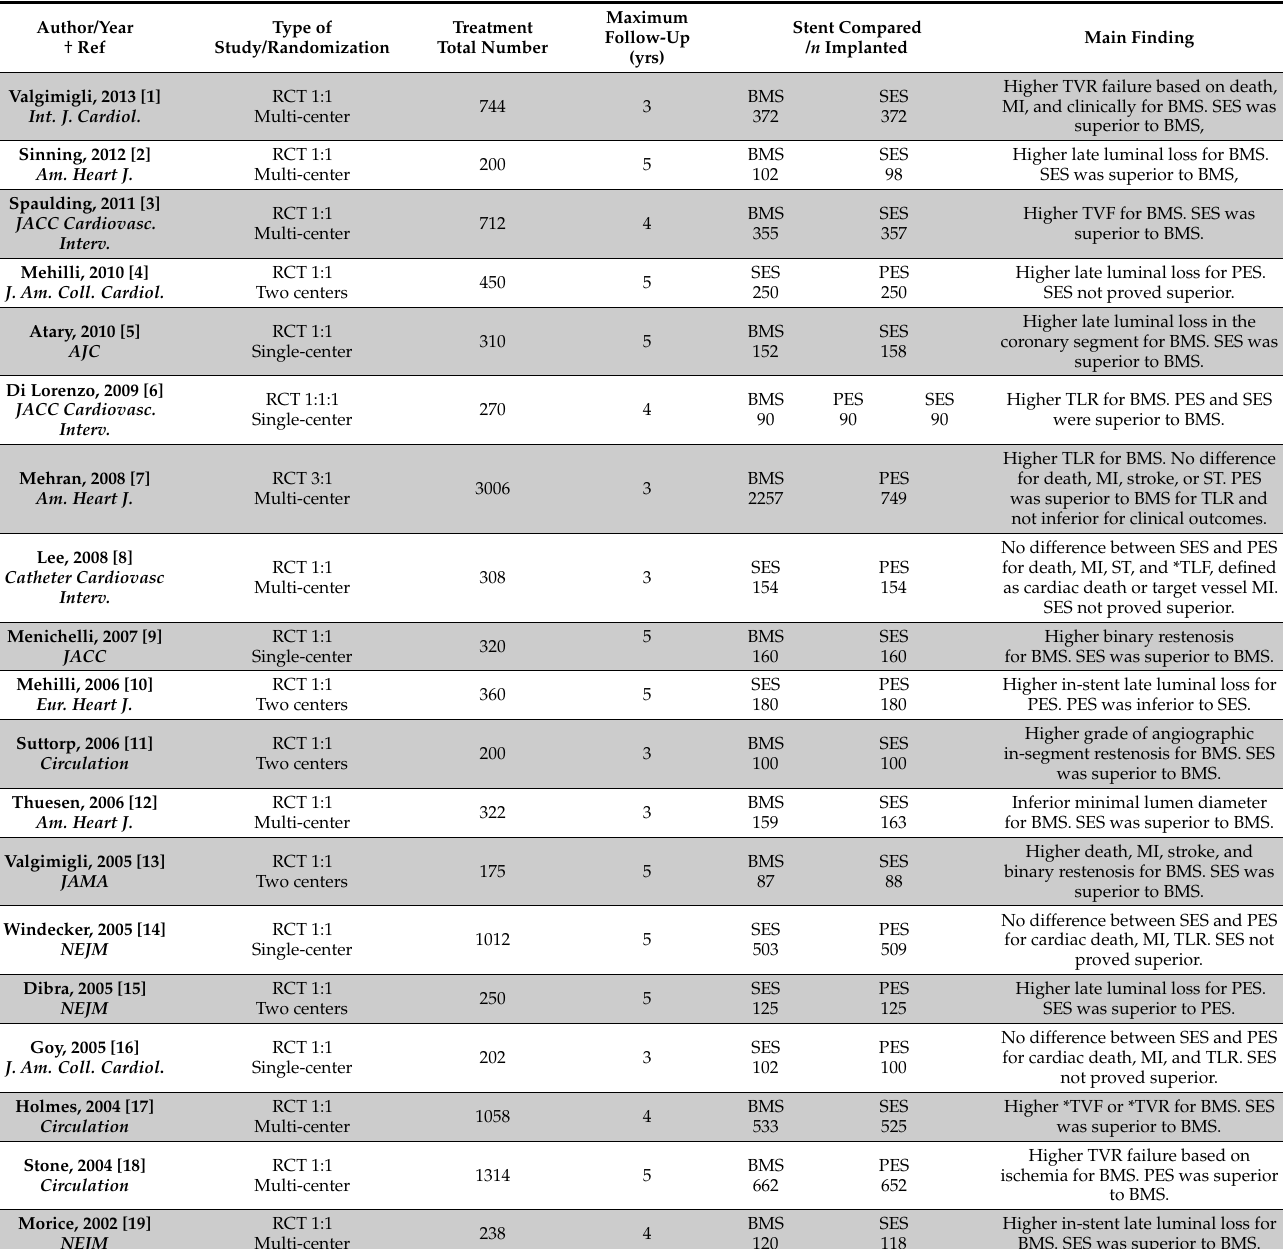
Table 1. Summary of Contemporary Series Comparing BMS and DES. Abbreviation. BMS = bare-metal stent; DES = drug-eluting stent; MI = myocardial infarction; PES = paclitaxel-eluting stent; RCT = randomized clinical trial; ST= stent thrombosis; SES